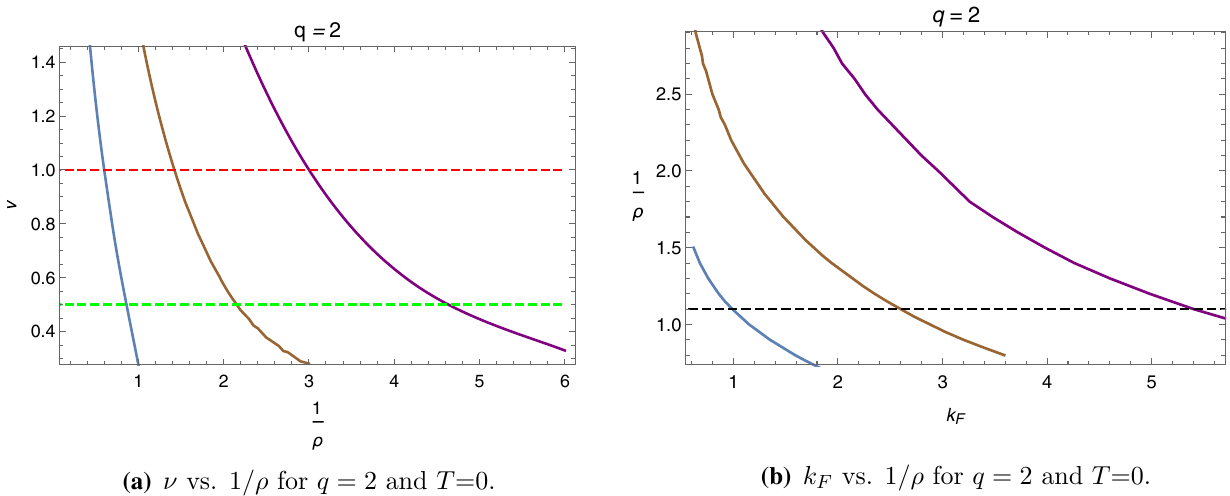
k /ρ for q = 2 and T =0. F vs. 1